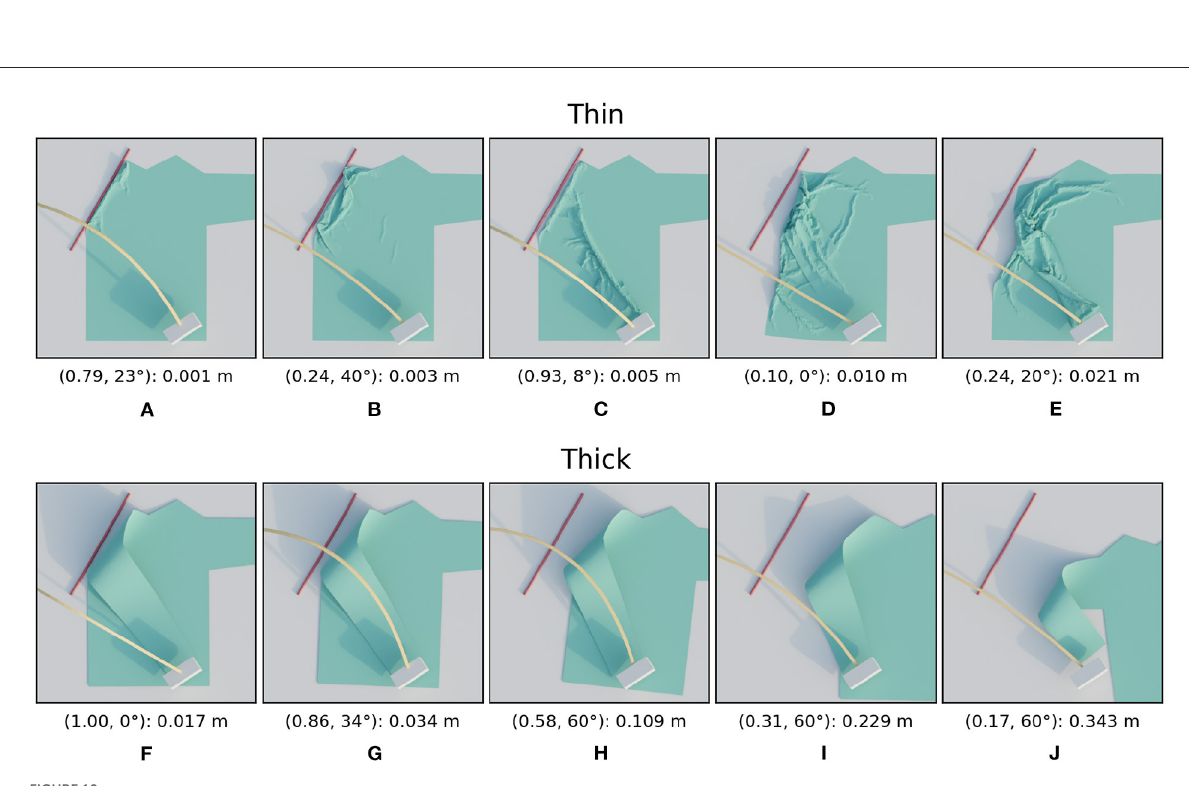
FIGURE10 Images of simulated results for the thickness variations. For each row, the images are ordered from best (left) to worst (right) result. The annotation below each image is in the following format: (height ratio, tilt angle): mean distance. The first row (A–E) shows the images for the thin material and the second row (F–J) for the thick